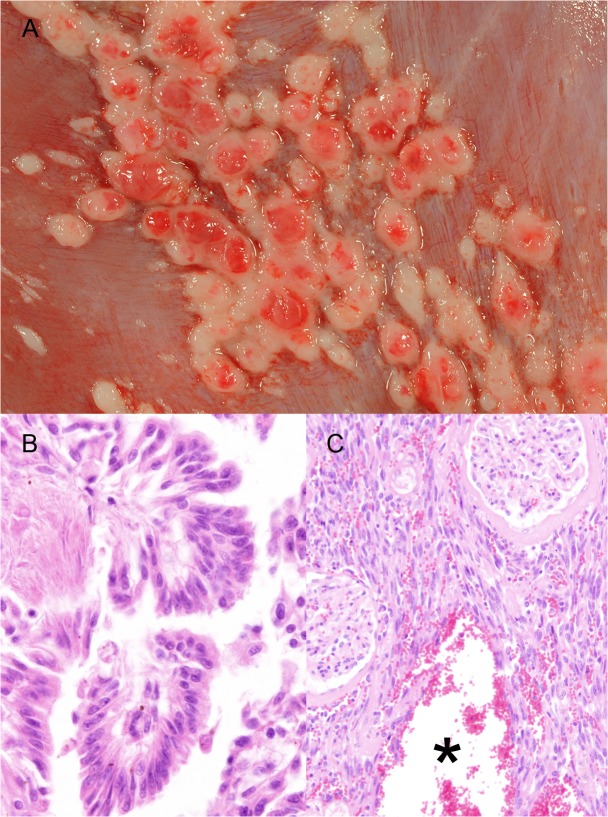
Pleural and vascular tumors in wild felids.A) Pleura costalis, tiger, 19 years, male (animal no 25). Mesothelioma of the diaphragmatic pleura characterized by numerous elevated grayish-red confluent nodules. B) Pleura, cheetah, 10 years, male (animal no 1). Epithelial component of a mesothelioma displaying a papillary growth pattern. H&E-staining. C) Kidney, cougar, 18 years, female (animal no 4). A hemangiosarcoma characterized by a large blood filled cavity (asterisk). H&E-staining.